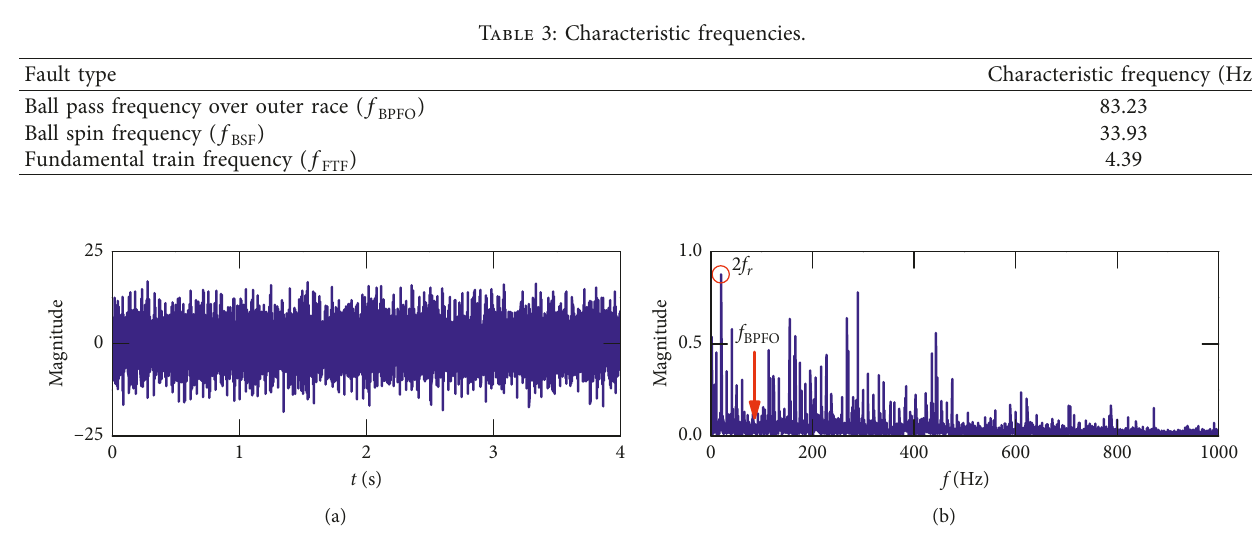
Figure 10: Bearing outer race fault signal and squared envelope spectrum: (a) time-domain waveform; (b) squared envelope spectrum.